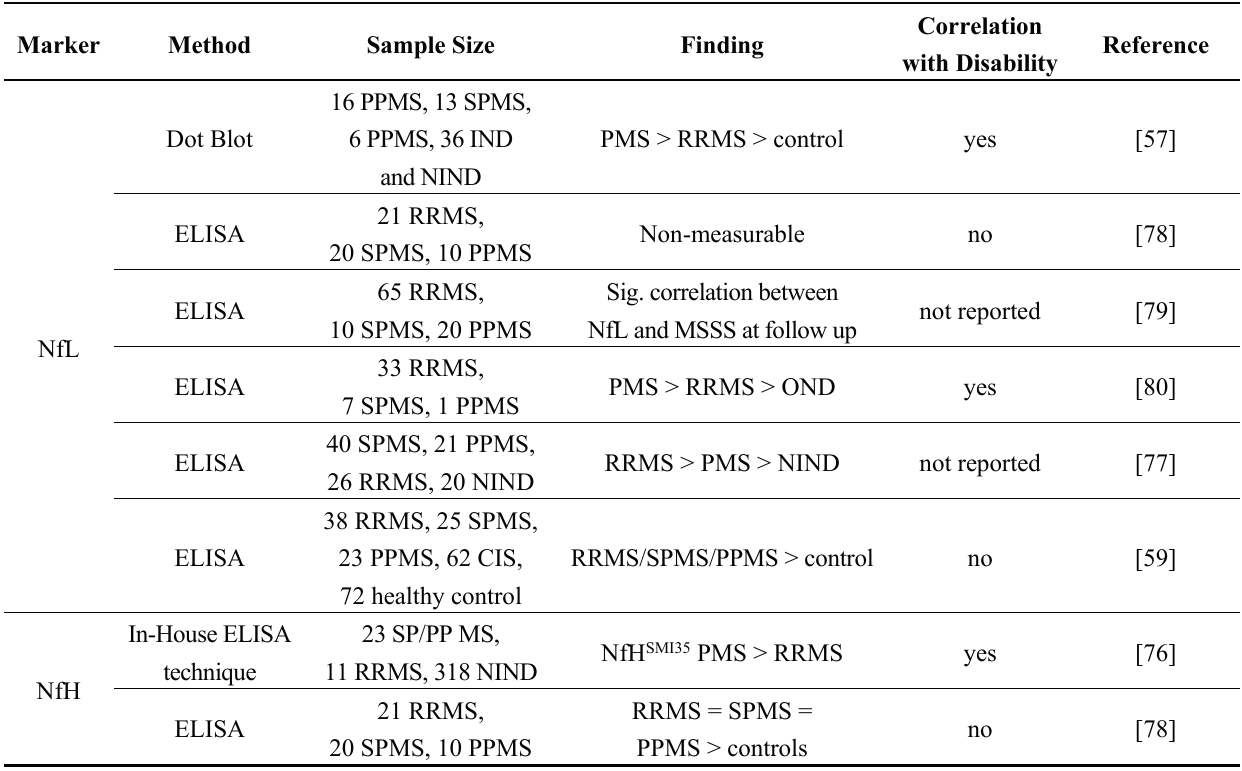
Table 2. Neurofilament CSF levels in primary progressive multiple sclerosis (PPMS) as compared to healthy controls, relapsing remitting (RRMS) and secondary progressive multiple sclerosis (SPMS) and other inflammatory- and non-inflammatory neurological diseases.